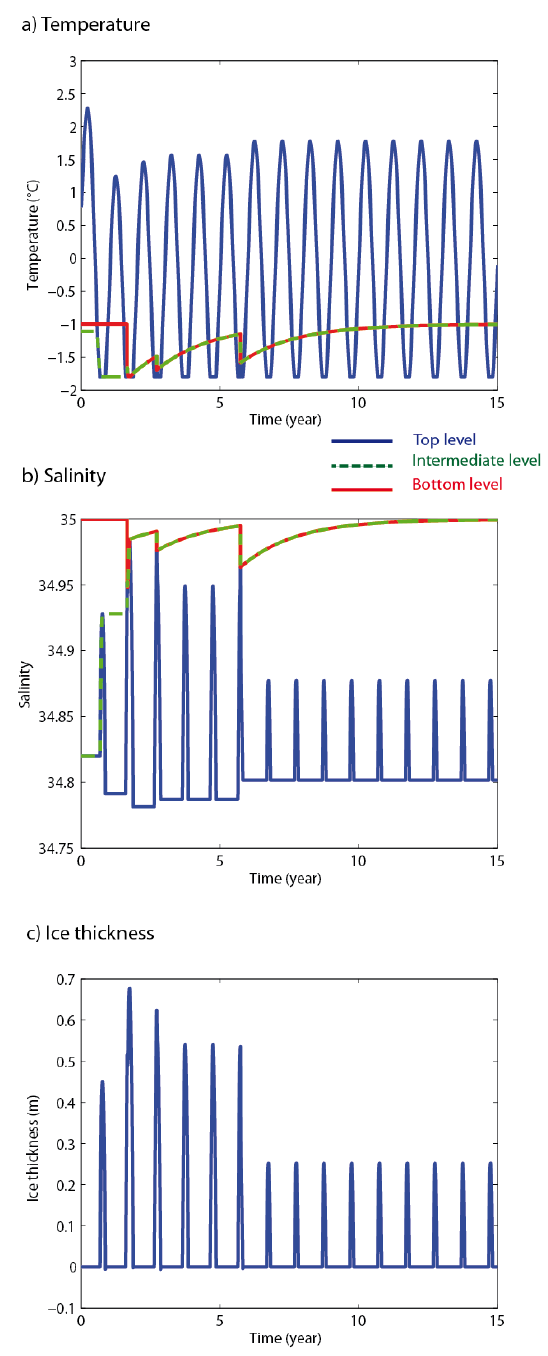
Fig. 8. (a) Temperature ( ◦ C), (b) salinity, and (c) sea ice thickness (m) in the three-level model in response to a reduction of the surface heat flux during the first year. The value of the top level is in blue, the intermediate level is in green, and the bottom one is in red. Because of the perturbation, strong sea ice formation initially destabilizes the water column but the downward transport of salt out of the top level finally leads to a stable water column during all the seasons after 7 years.